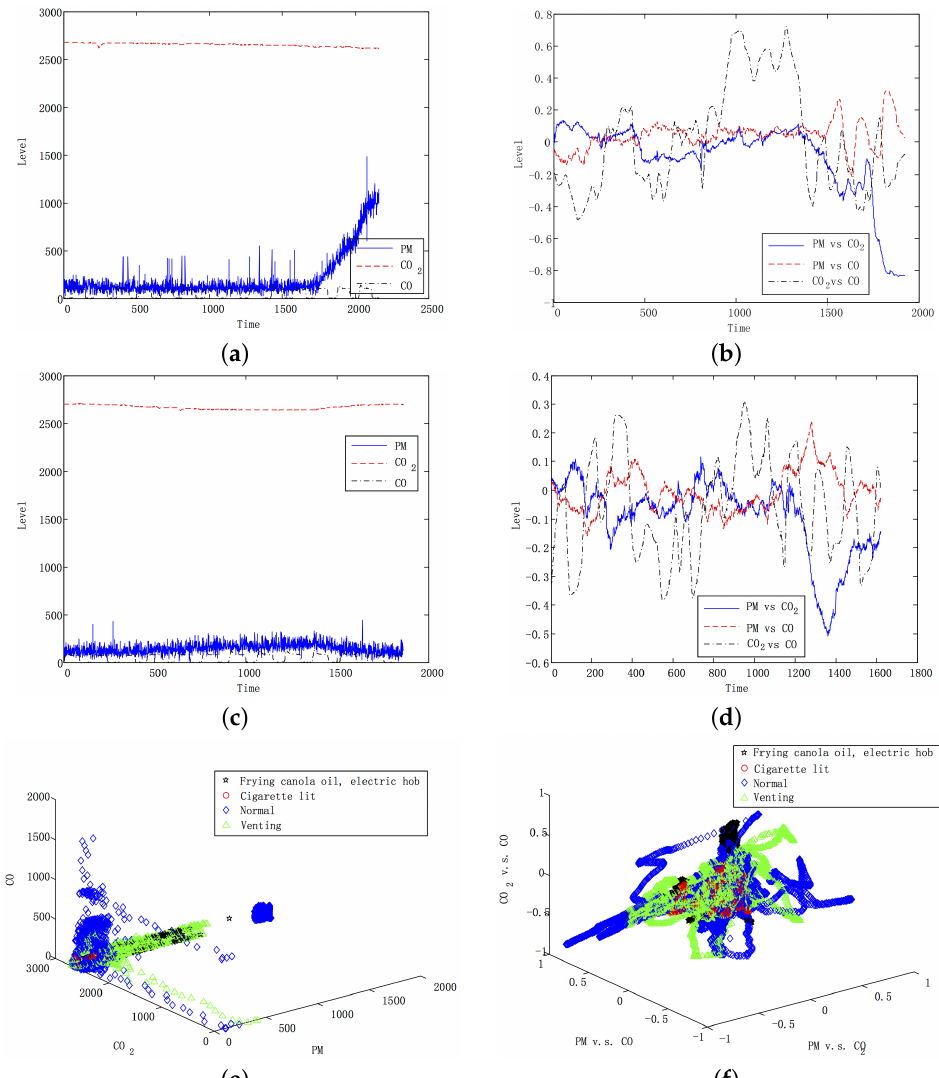
Figure 3. ( a ) Levels of contaminants obtained from PACMAN for event “frying canola oil, electric hob”; ( b ) deterministic components obtained after data filtering for event “frying canola oil, electric hob” ( c ) levels of contaminants obtained from PACMAN for event “smoking”; ( d ) deterministic components obtained after data filtering “smoking”; ( e ) the native organization of contaminants for the two events with sessions “venting” and “normal” distributed in 3D space; ( f ) the filtered data for the two events with sessions “venting” and “normal” distributed in 3D